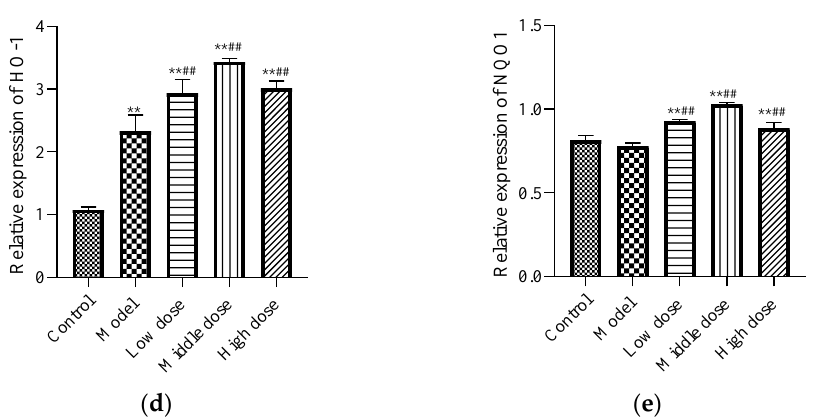
Figure 6. Effects of LBP on Nrf2-related protein expression. Ⅰ , control; Ⅱ , model; Ⅲ , low dose; Ⅳ , middle dose; Ⅴ , high dose. The results are expressed as the mean ±SD, n = 10. * Statistically significant compared to control group, * p < 0.05, ** p < 0.01. # Statistically significant compared to model group, # p < 0.05, ## p < 0.01. ( a ) Western blot analysis of proteins related to nuclear factor erythroid 2-related factor 2 (Nrf2) signaling pathway. ( b ) Expression of Nrf2; ( c ) Expression of Kelch-like ECH-associated protein 1 (Keap1); ( d ) Expression of Oxygenase-1 (HO-1) ( e ) Expression of NAD(P)H dehydrogenase, quinone 1 (NQO1).